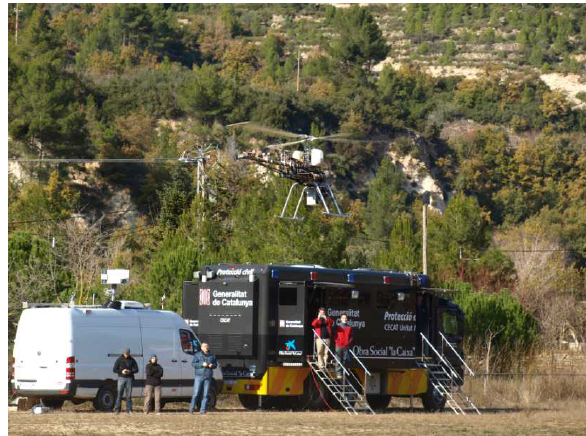
Figure 4: Unmanned Aircraft and Control Station on November, 25th -the first CLOSE-SEARCH test